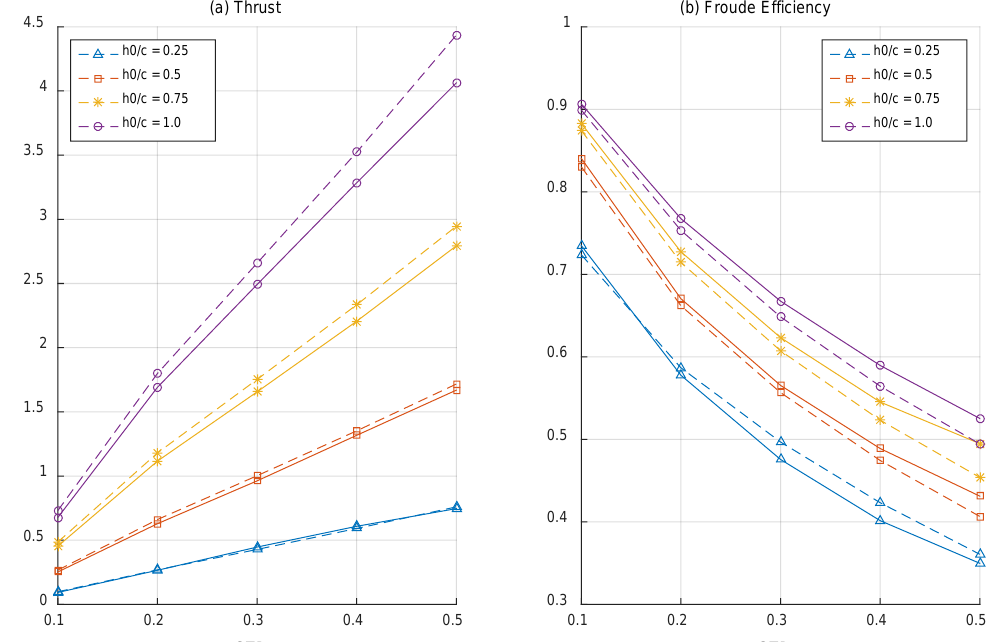
Figure 17. Propulsive performance of a chord-wise flexible foil with E = 3.45 10 5 Pa NACA 0012 flapping foil (solid lines) compared to the equivalent rigid foil (dashed lines). ( a ) Thrust coe ffi cient and ( b ) Froude e ffi ciency for U = 0.3 m/s, θ o = 10 ◦ , ψ = 90 ◦ , x R = 1/3 c , as functions of Strouhal number.